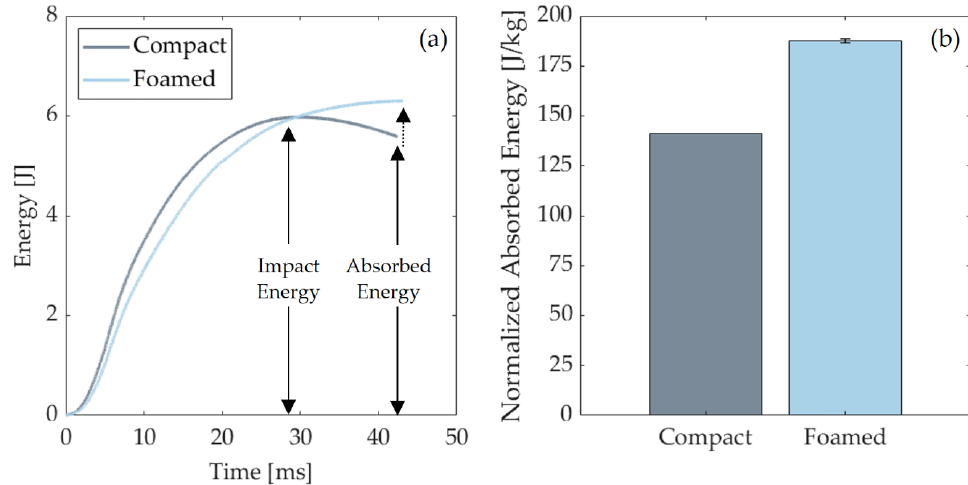
Figure 17. ( a ) Energy vs. time output. ( b ) Normalized absorbed energy for 5 J energy levels. Samples were normalized to their respective